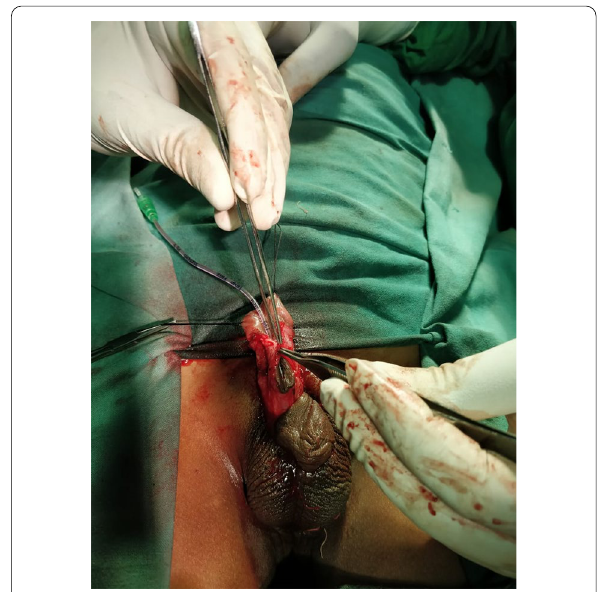
Fig. 4 Intraoperative picture of a 6 years old with mid-penile hypospadias showing adequate mobilisation of